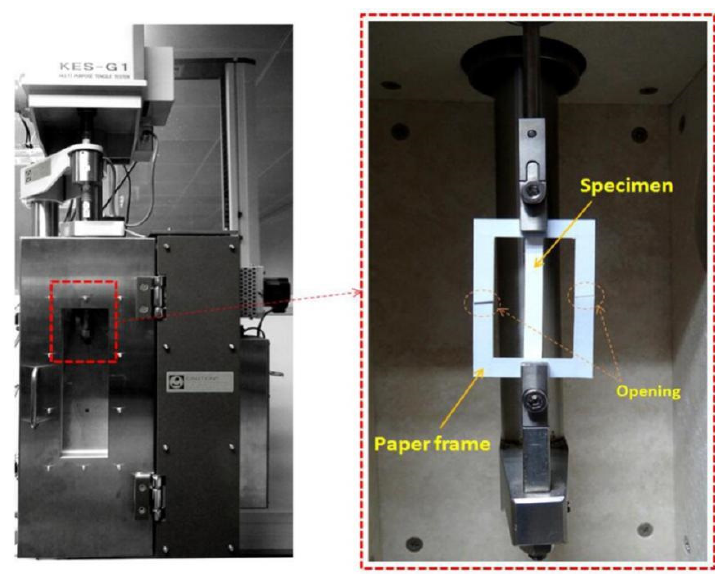
Figure 5. Tensile testing system for single nanofibers.